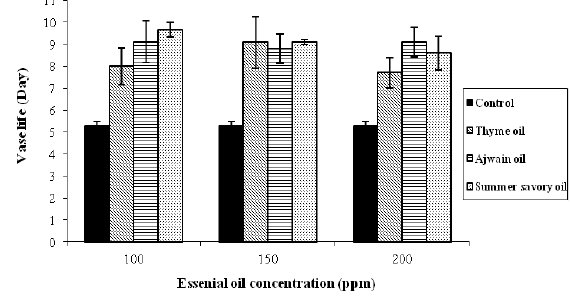
Fig. 3. Effect of different concentrations of Thyme, Ajwain and Summer savory essential oils on vase-life of carnation cut flowers (cv. ‘Yellow